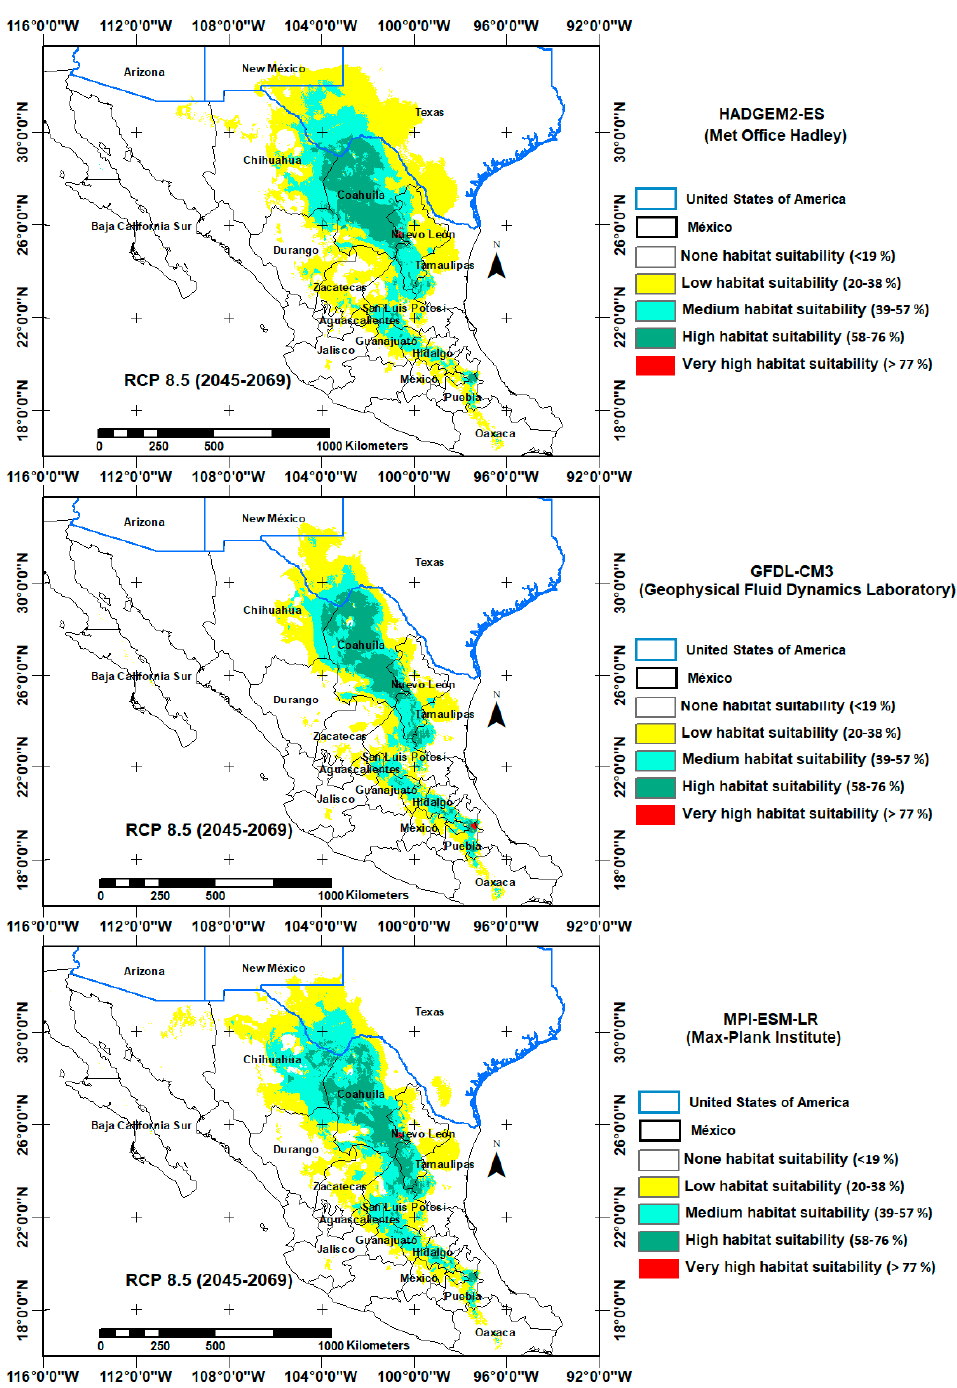
Figure 6. Candelilla’s potential distribution areas with a RCP of 8.5, under three GCMs for Mexico and The USA.